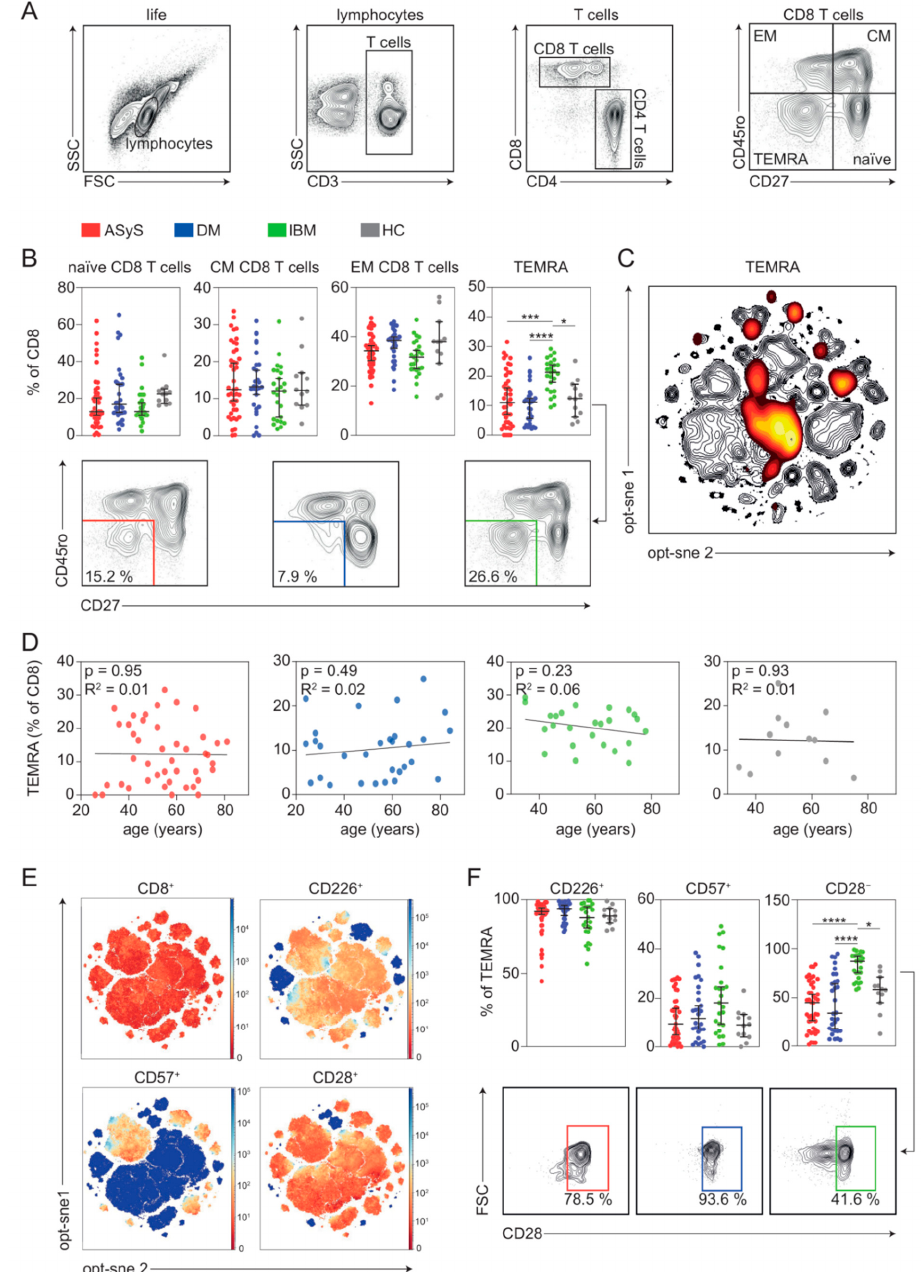
Figure 3. Topography of the CD8 T cell population in IIM. ( A ) Representative flow cytometry gating strategy for immune cell subsets. ( B ) Frequencies of CD8 T cell subsets in IIM and representative flow cytometry plots. ( C ) Global optimization of tSNE (opt-sne) projection of the CD8 T cell population for all patients concatenated and overlaid. The TEMRA subset is overlaid in red. ( D ) Linear regression model displaying association of TEMRA levels as % of CD8 + T cells and age. ( E ) Global opt-sne projection of CD8 + T cells for all patients concatenated and overlaid. Expression of indicated proteins is colour coded. ( F ) Frequencies of indicated TEMRA cells and representative flow cytometry plots. Each point represents an individual ASyS (red), DM (blue), IBM (green) patient or healthy controls (grey). Significance was determined by Kruskal–Wallis test: * p < 0.05, *** p < 0.001, and **** p < 0.0001. Abbreviations: ASyS = anti-synthetase syndrome; CM = central memory; DM = dermatomyositis; EM = effector memory; IBM = inclusion body myositis; TEMRA = terminally differentiated effector memory T cells; tSNE = t-distributed stochastic neighbour